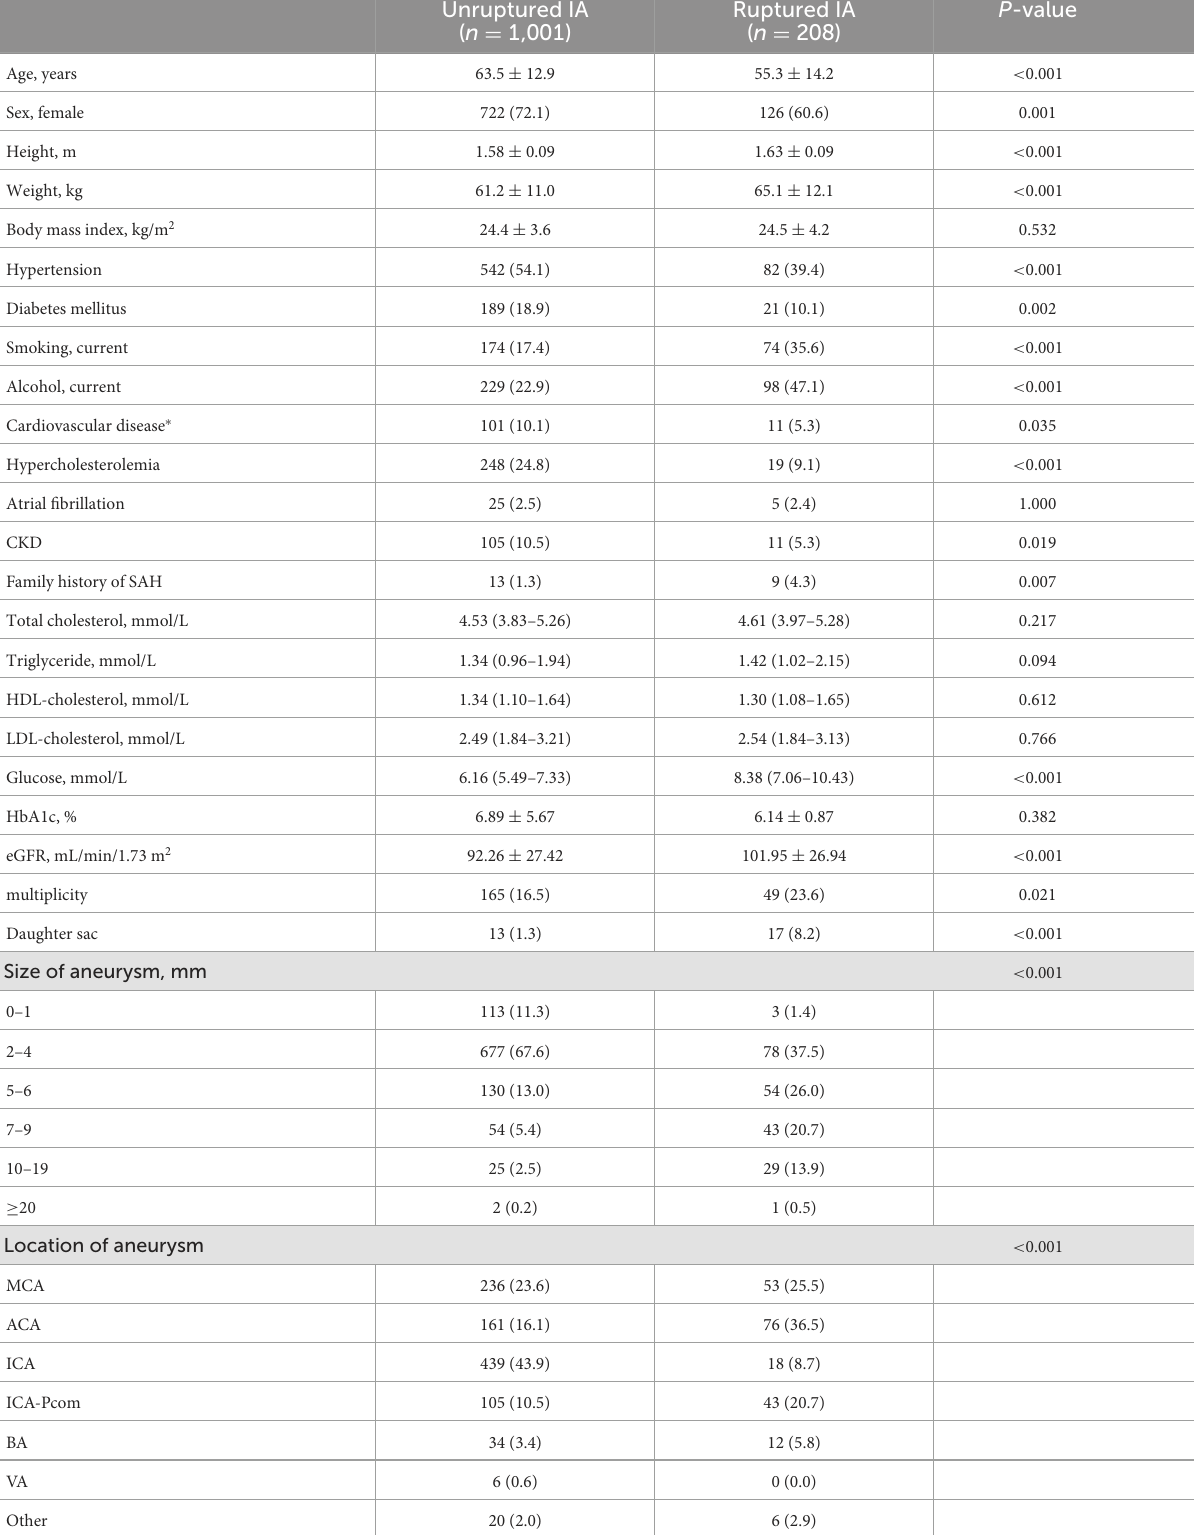
TABLE 1 The distribution of demographic and clinical characteristics among unruptured and ruptured